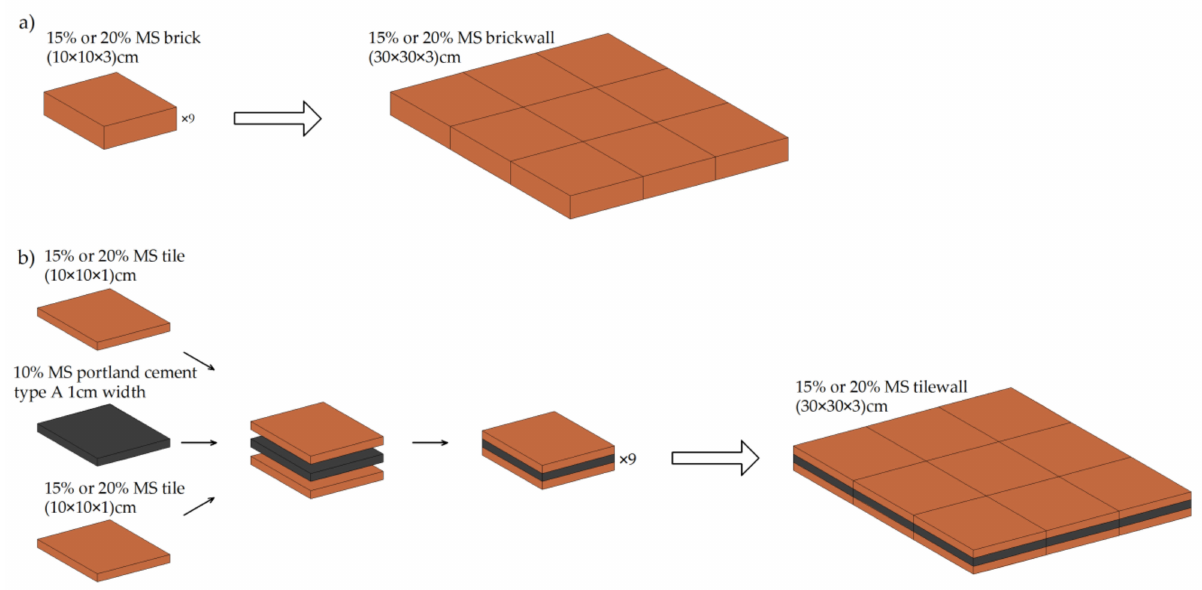
Figure 10. Tested: ( a ) bricks, ( b ) tiles, and larger elements made up of them (after [67]). Ceramic elements containing a metallurgical slag admixture were tested in study